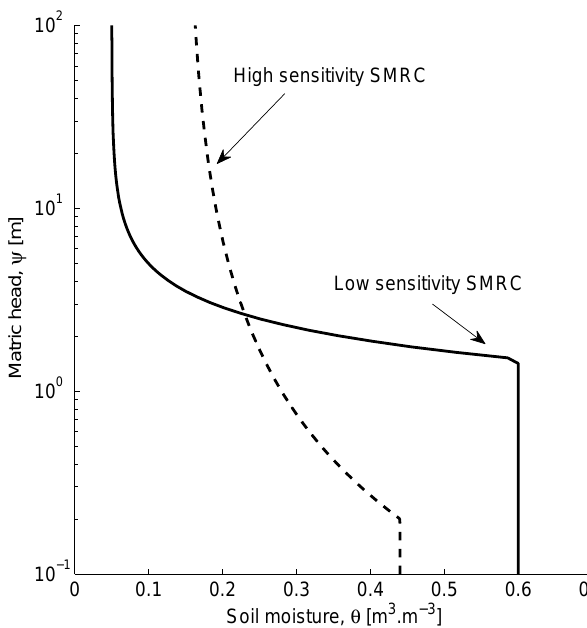
Fig. 9. Soil moisture retention curve (SMRC) for which the sensitivity of the simulated soil moisture to textural changes is the highest and the lowest, respectively.